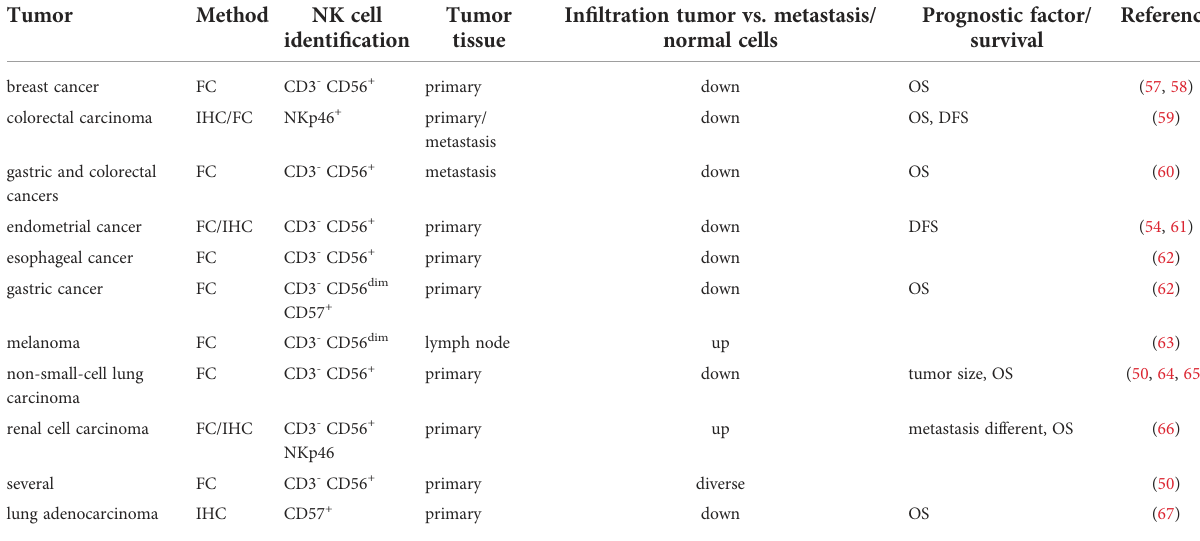
TABLE 2 NK cell in fi ltration and its prognostic value.